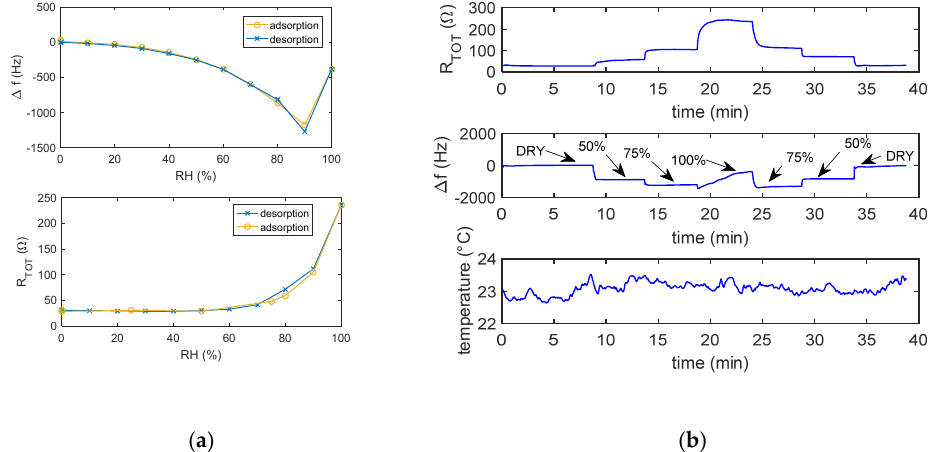
Figure 6. Response of functionalized QCM by 4 μ g of solution by varying humidity up to RH = 100%. ( a )—measured parameters in steady state conditions as a function of the RH levels; ( b )—the transient behavior obtained with step changes in the humidity as a function of time (the duration of each RH% step is 4 min).